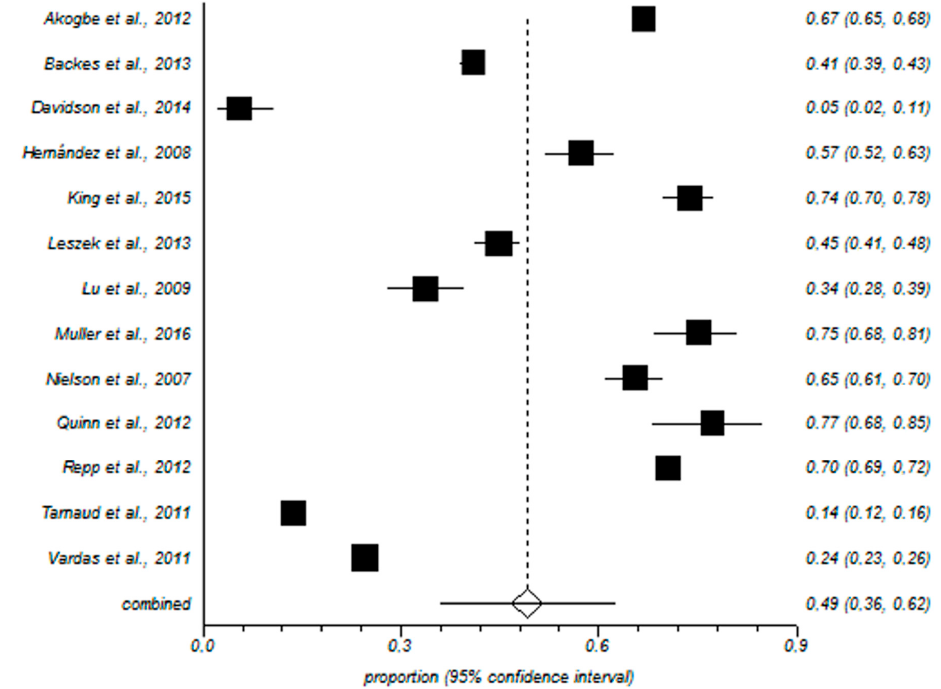
Figure 2. Forest plot of any HPV prevalence. Any HPV Prevalence informed by each study and the meta-analytic estimation.